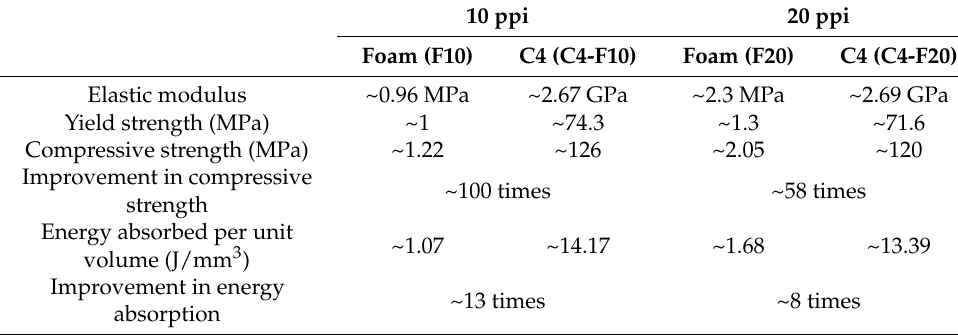
Figure 6. Compressive stress ‐ strain behaviors of ( a ) 10 ppi SiC foam and its C4 ( b ) 20 ppi SiC foam and its C4. Table 7. Inferences from Compression Tests.